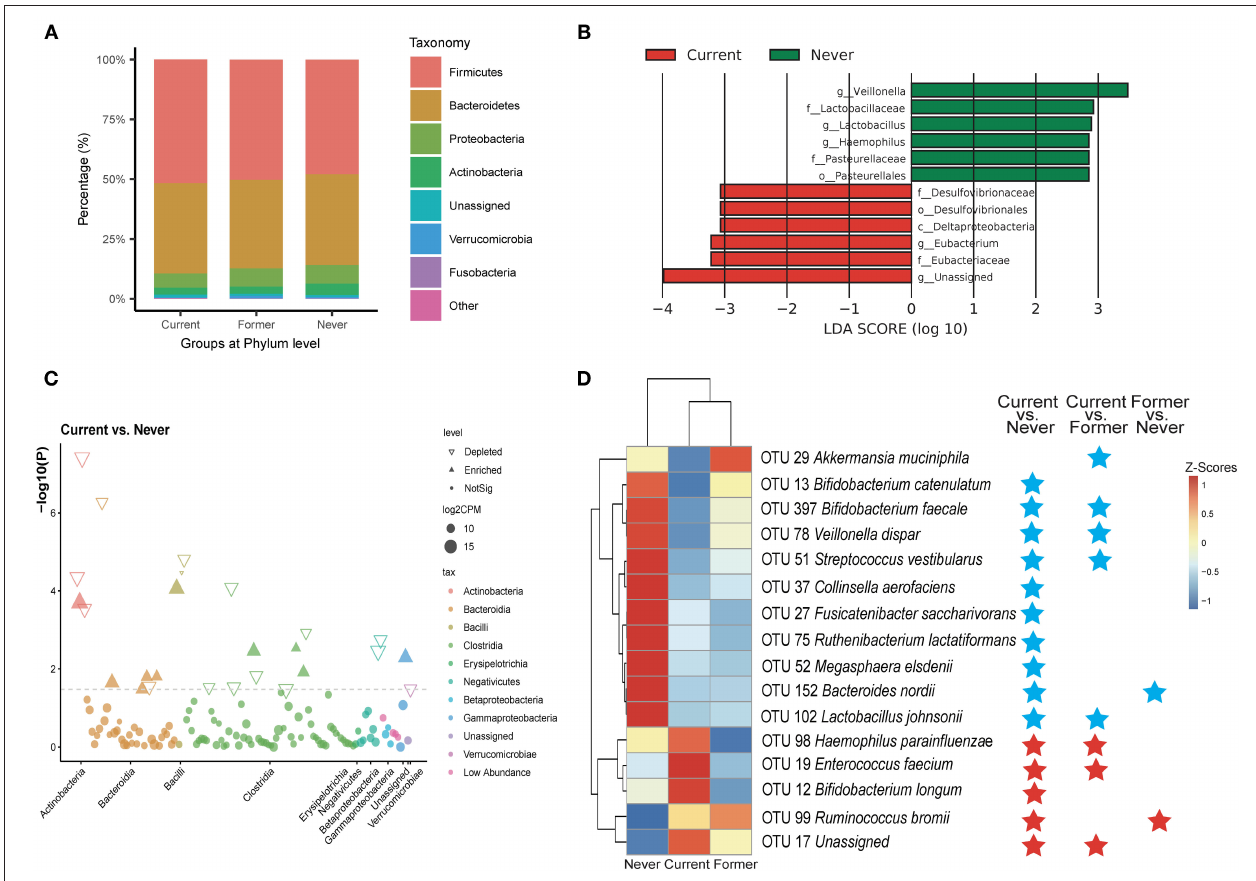
FIGURE 1 | Alterations in the composition of gut microbiota associated with smoking status. (A) Dominant phyla in each group. (B) Linear discriminant analysis (LDA) effect size (LEfSe) analyses of the differential taxa between current and never smokers. (C) A Manhattan plot showing the distribution of differential taxa. (D) A heatmap illustrating the relative abundance of smoking-associated operational taxonomic units (OTUs) across the three groups. A threshold of FDR < 0.05 calculated by the edgeR test was considered statistically significant. Blue stars indicate the depleted OTUs in comparison; red stars indicate the enriched OTUs.